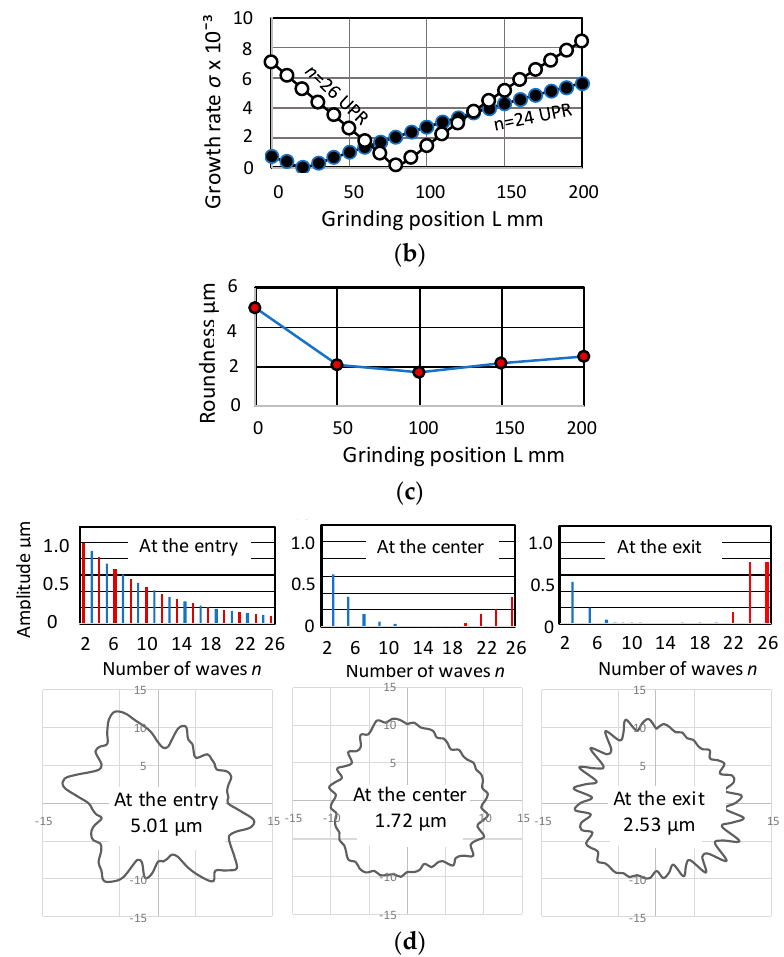
Figure 7. Simulation I: Unstable process RSI = 3.07. ( a ) Characteristic root distributions; ( b ) Growth rates of 24 UPR and 26 UPR; ( c ) Roundness vs. grinding positions; ( d ) Progress of roundness.